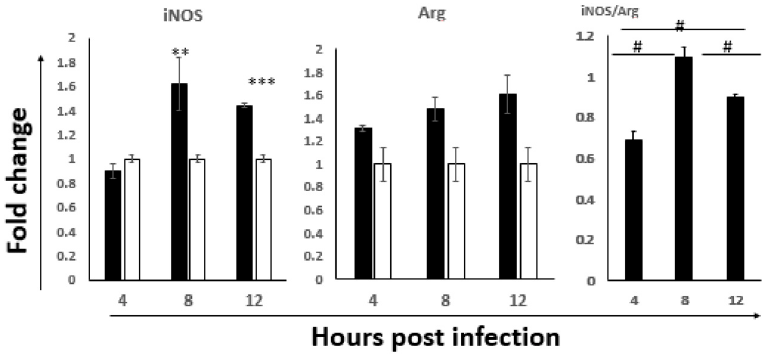
Figure 3. The expression of M1 and M2 hallmarks in the ILP cells of NN1172-infected birds at the early stage of infection. The mRNA expression levels of M1 phenotype Macrophage (iNOS) and iNOS/Arg ratio was calculated at each time point. Results represent mean ± SEM, n = 5. (** p < 0.01; of iNOS/Arg ratio between each time point post-infection.